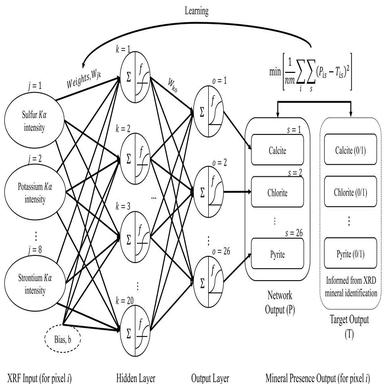
Schematic of the training scheme for an Artificial Neural Network (ANN) in the SMART mineral mapper. This ANN is depicted with 1 hidden layer (for graphical simplicity) where k is the index for neurons in the hidden layer, j is the input attribute index (8 element XRF intensities) and s is the output attribute index. P is the network prediction and T is the target output (known). The learning process involves updating the weights, all Wjk and Wko, by fitting the predictions to the targets. Variable n is the